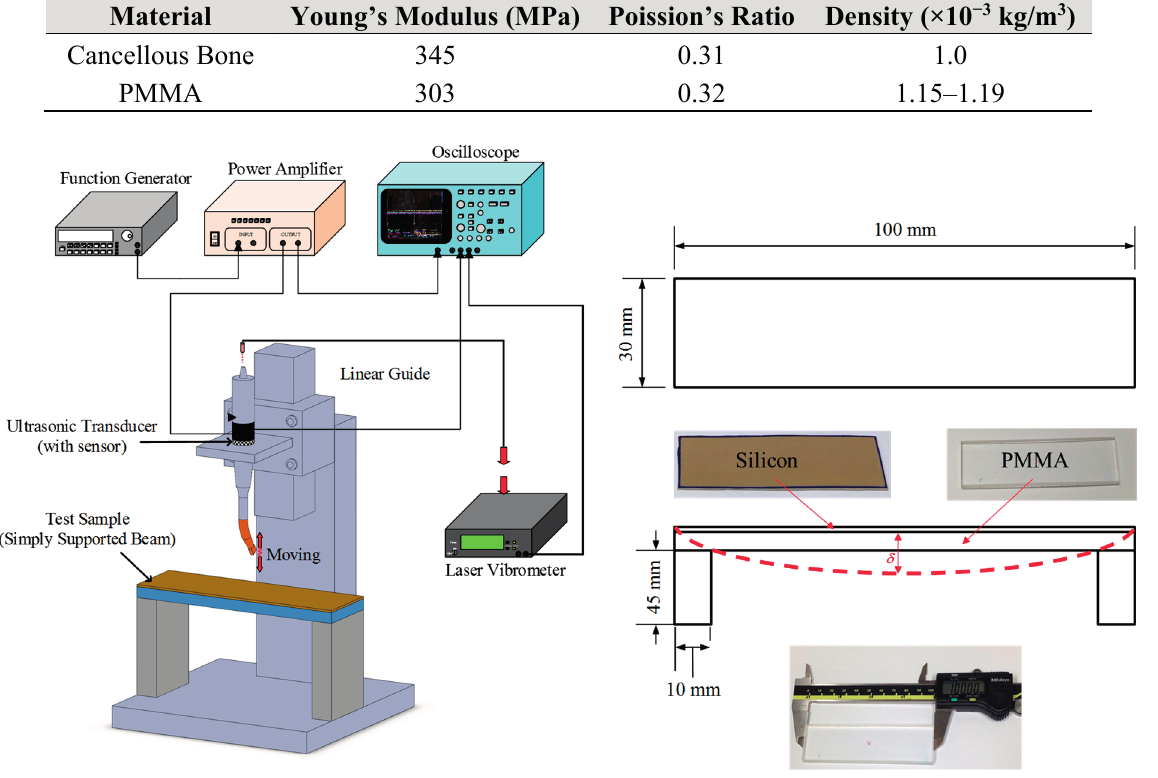
Figure 6. Experimental set-up for investigate sensor performance during contact with test